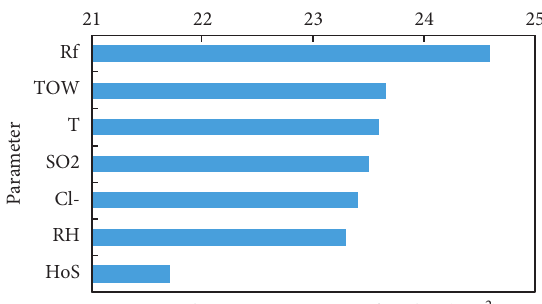
Figure 20: Sensitivity of input parameters to K .